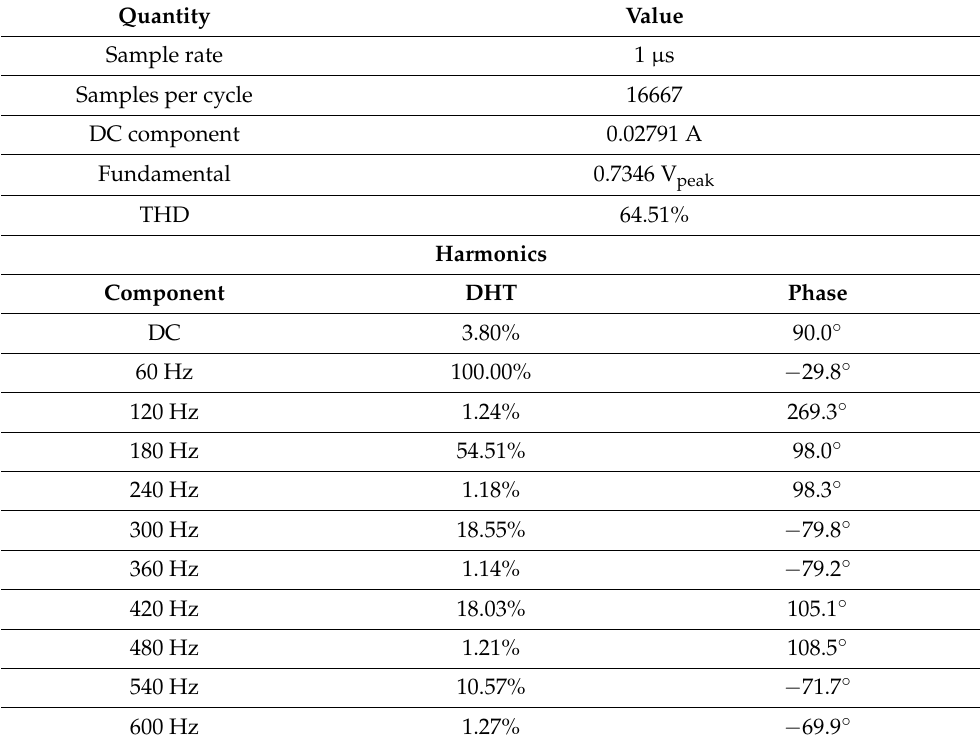
Table 12. Spectrum analysis of the rectifier current.